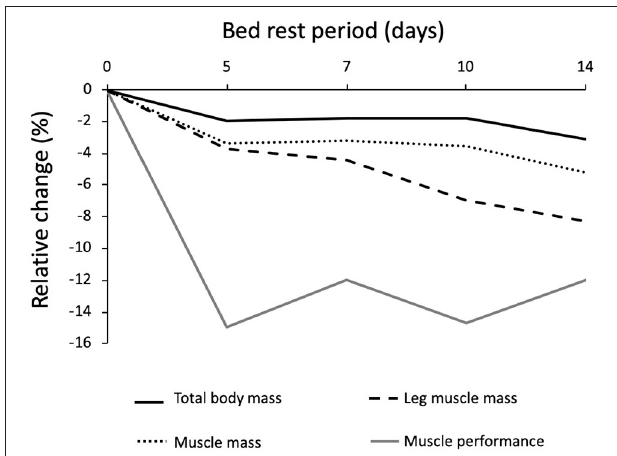
FIGURE 4 | Relative changes of body mass, muscle mass and muscle performance after different periods of bed rest in 59 pooled participants. Data are reported as percent differences from the baseline. Solid black line = total body weight; Dotted black line = muscle mass; dashed black line = leg muscle mass; Solid gray line = muscle efficiency; total n = 59 grouped by the duration of bed rest.